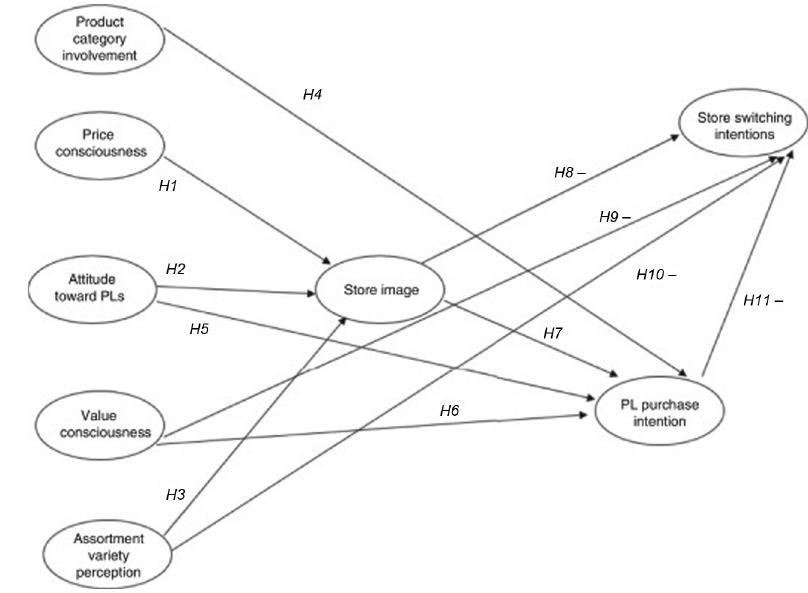
Figure 1. Model of proposed